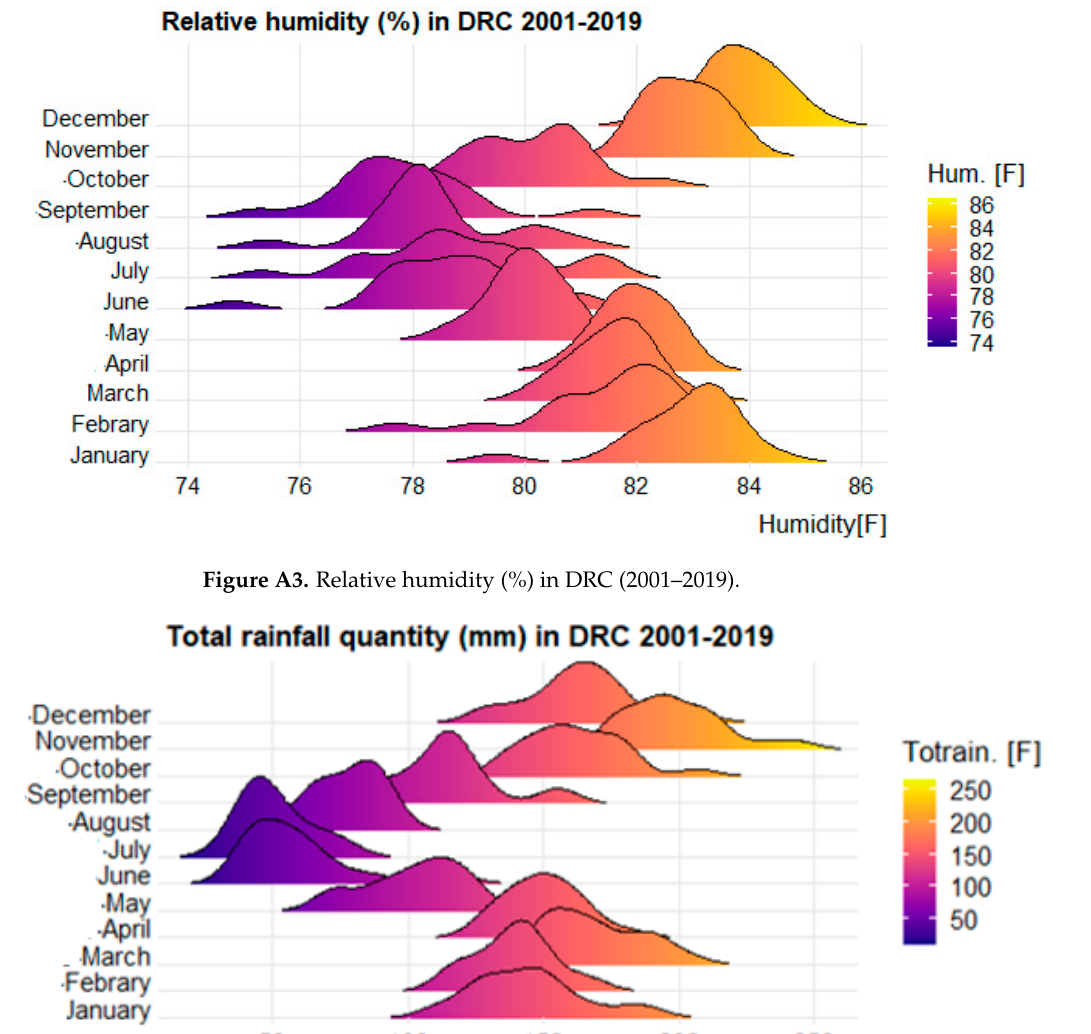
Figure A4. Total rainfall quantity (mm) in DRC (2001–2019).